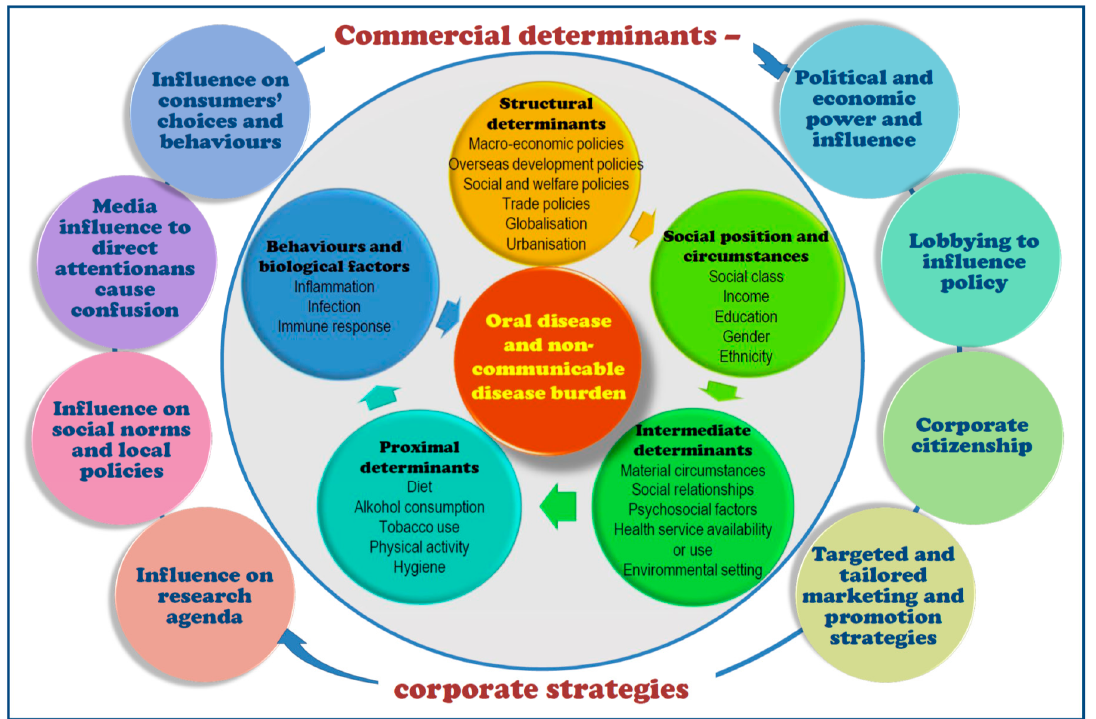
Figure 2. Social and commercial determinants of oral diseases.